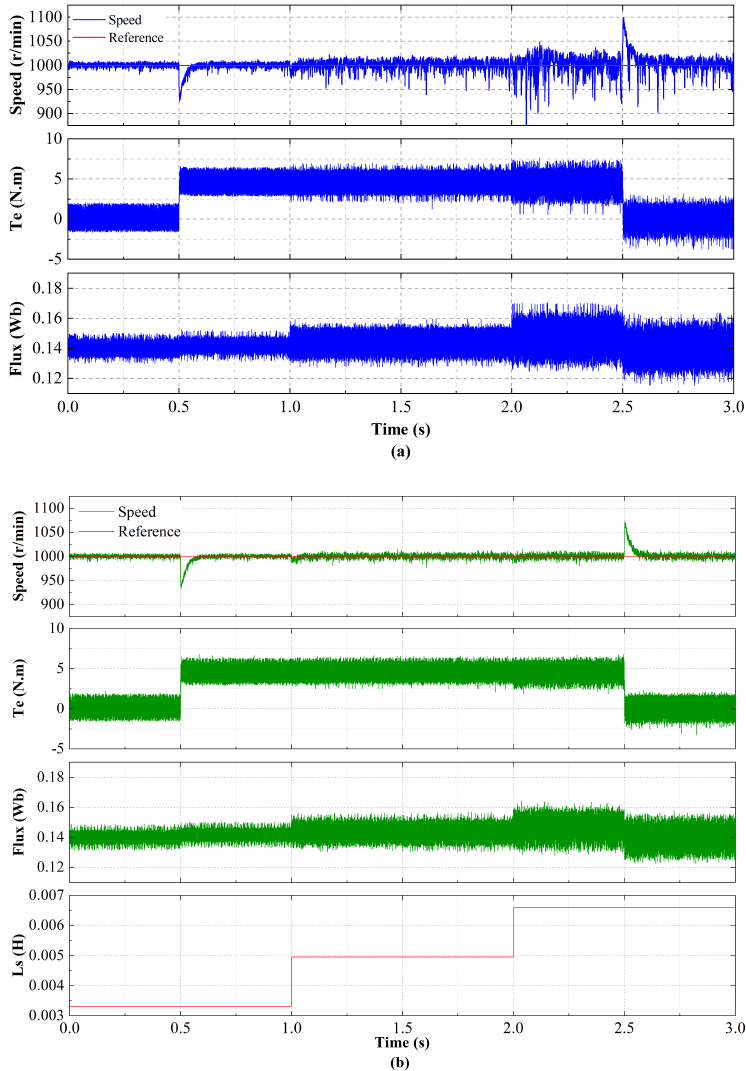
Figure 9. The experimental results of conventional PPTC and proposed MF-PPTC in the case of stator inductance mismatch. ( a ) Conventional PPTC. ( b ) Proposed